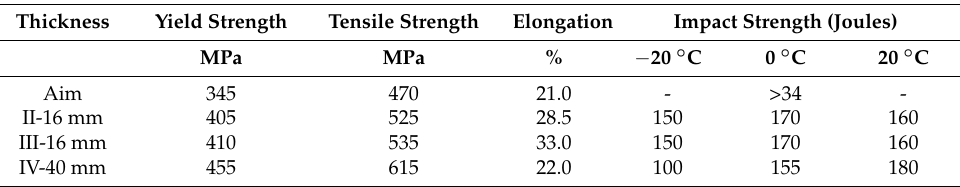
Table 2. Peritectic (0.16%) low Mn-MicroNb mechanical properties *.